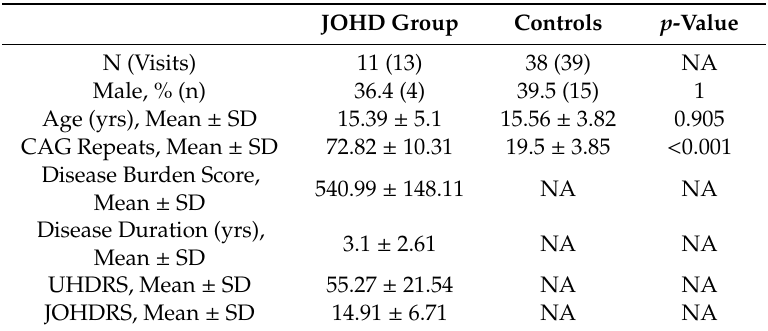
Table 1. Demographics by